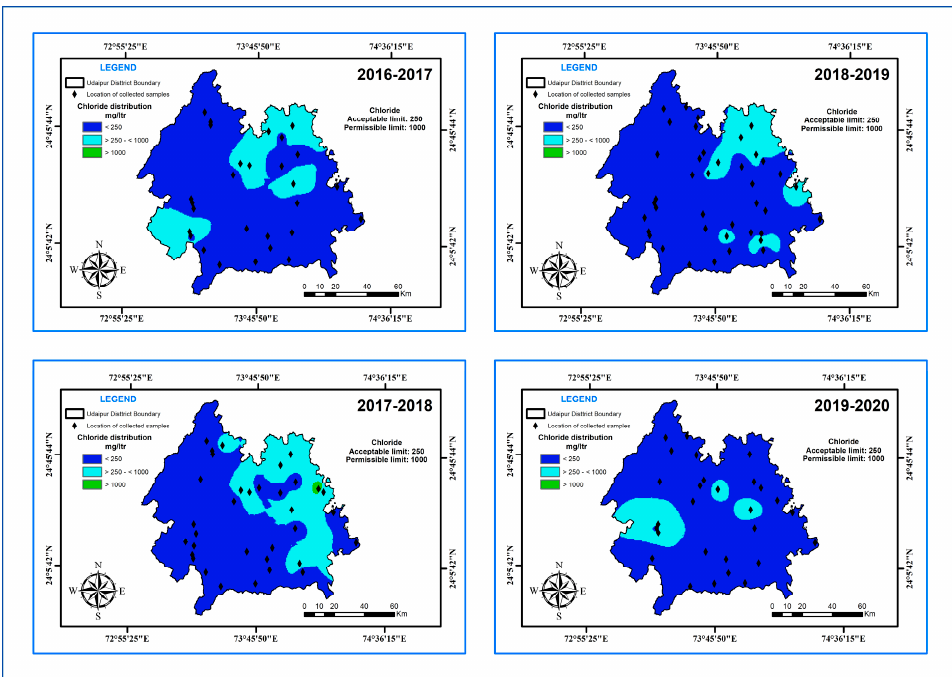
Figure 15. The changing distribution of chloride from 2016–2018 in the study area.